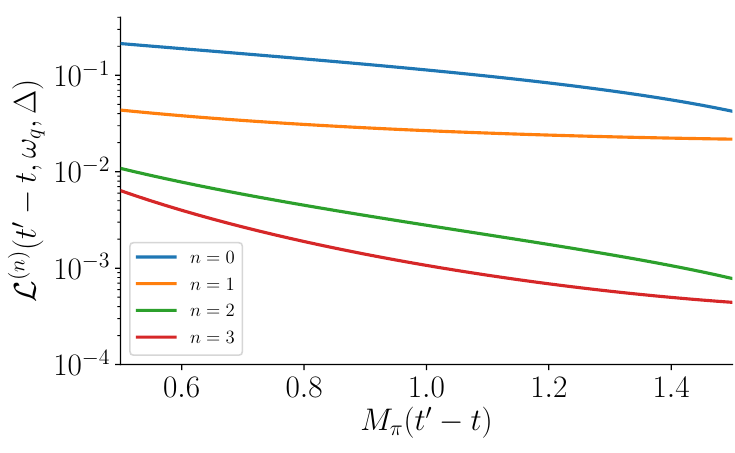
Figure 5 . Plot of the first few L ( n ) ( t 0 − t, ω q , ∆) functions, defined in eq. (3.31) of the main text, vs ( t 0 − t ) . Here we consider the functions in the case of two degenerate particles with mass m π and with ω q = 3 m π and ∆ = m π